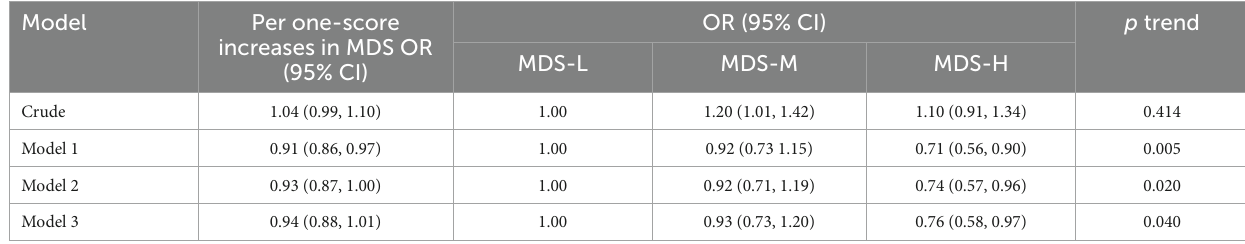
TABLE 2 Logistic regression analysis for the risk of hypertension according to the MIND diet score in the whole population.